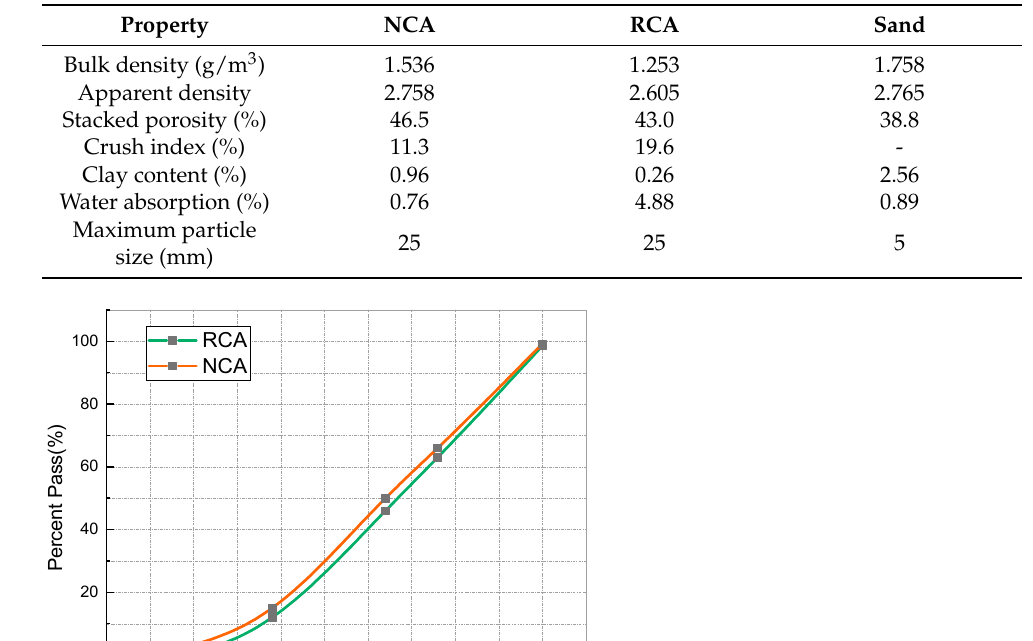
Figure 2. Natural coarse aggregate (NCA), RCA and river sand. Table 3. Physical properties of the main materials.